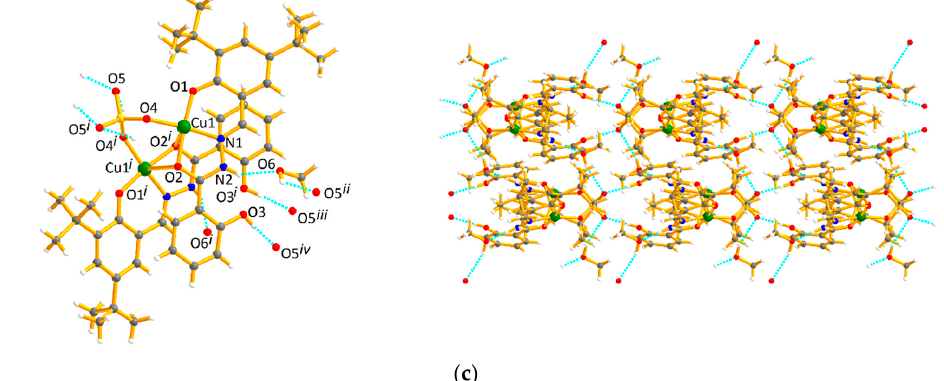
Figure 1. Molecular structures of complexes 1 ( a ); 2 ( b ) and 3 ( c ) with partial atom labeling schemes and respective structural representations of the 3D networks (in 1 and 3 ) and dimeric units (in 2 ) generated by hydrogen bond interactions (in dashed blue lines). In 1 and 3 , only one of the components of the disordered terc- butyl group is shown. Symmetry operations to generate equivalent atoms: 1 : ( i ) ´ 1 + x, y, z; ( ii ) x, ´ 1 + y, z; ( iii ) x, 1 + y, z; ( iv ) 1 + x, y, z; ( v ) 1 ´ x, 2 ´ y, 1 ´ z; ( vi ) 2 ´ x, 1 ´ y, 1 ´ z. 2 : ( i ) ´